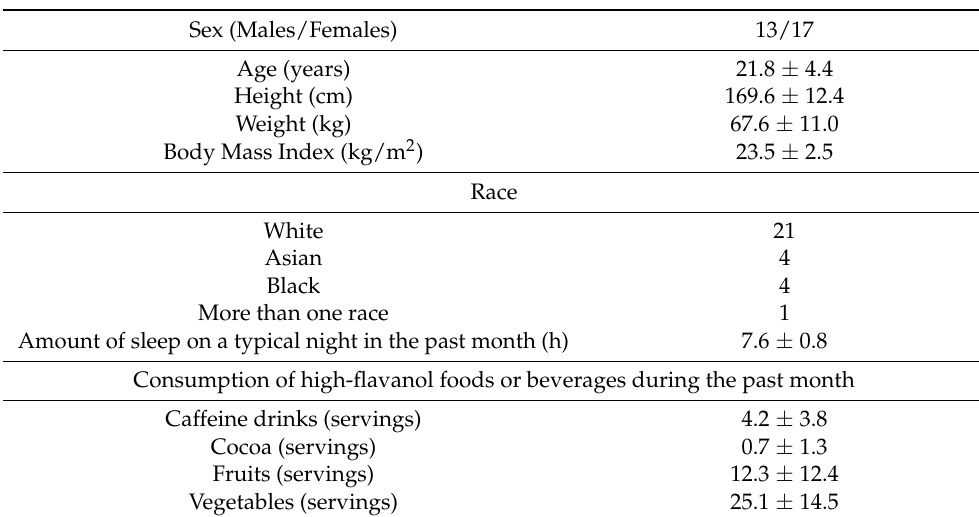
Table 3. Participant